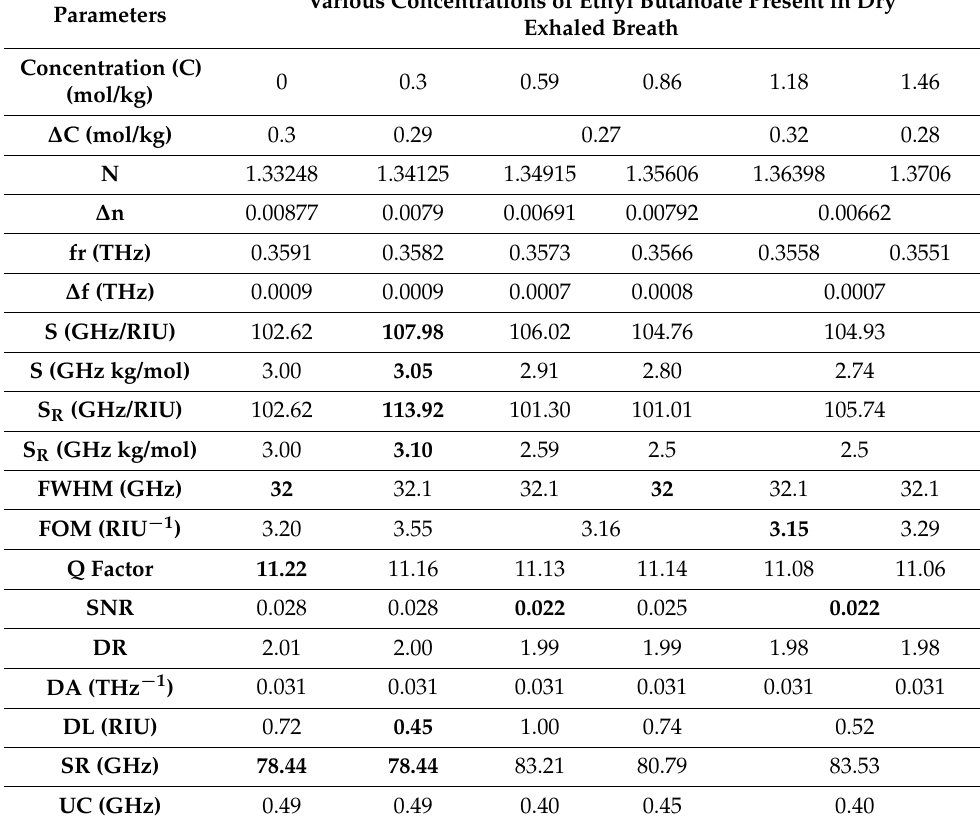
Table 1. Graphene-metasurface-inspired sensor’s performance for Cu 2+ Detection.